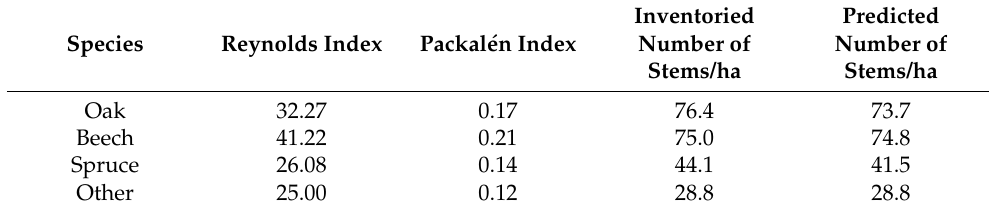
Figure 8. Cross-validation accuracy for the three components. Red stars correspond to the three component accuracy values for the global NN.